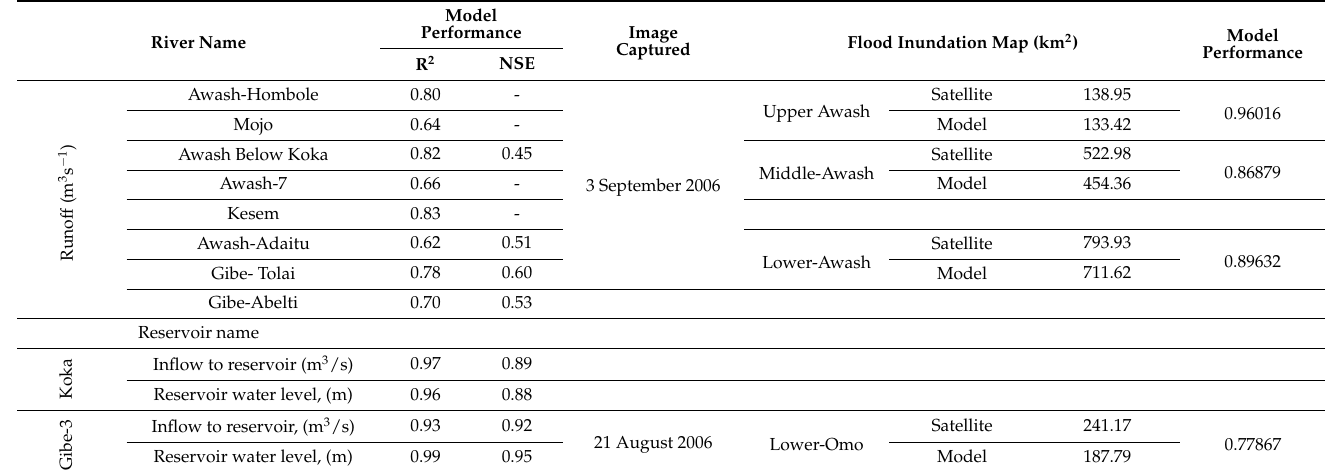
Table 1. Forecast model performance evaluation